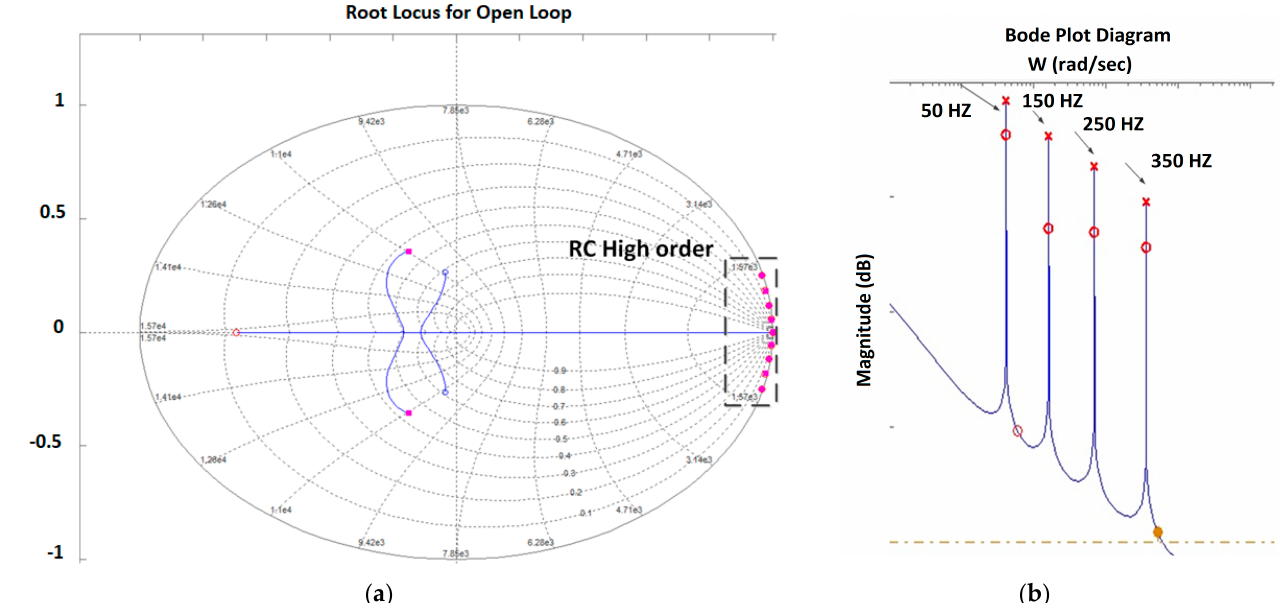
Figure 15. The root locus ( a ) and Bode plot diagram ( b ) for the RC control. Finally, in order to evaluate its robustness, the proposed voltage control approach is applied within different operating scenarios. In this line, different loading conditions in-